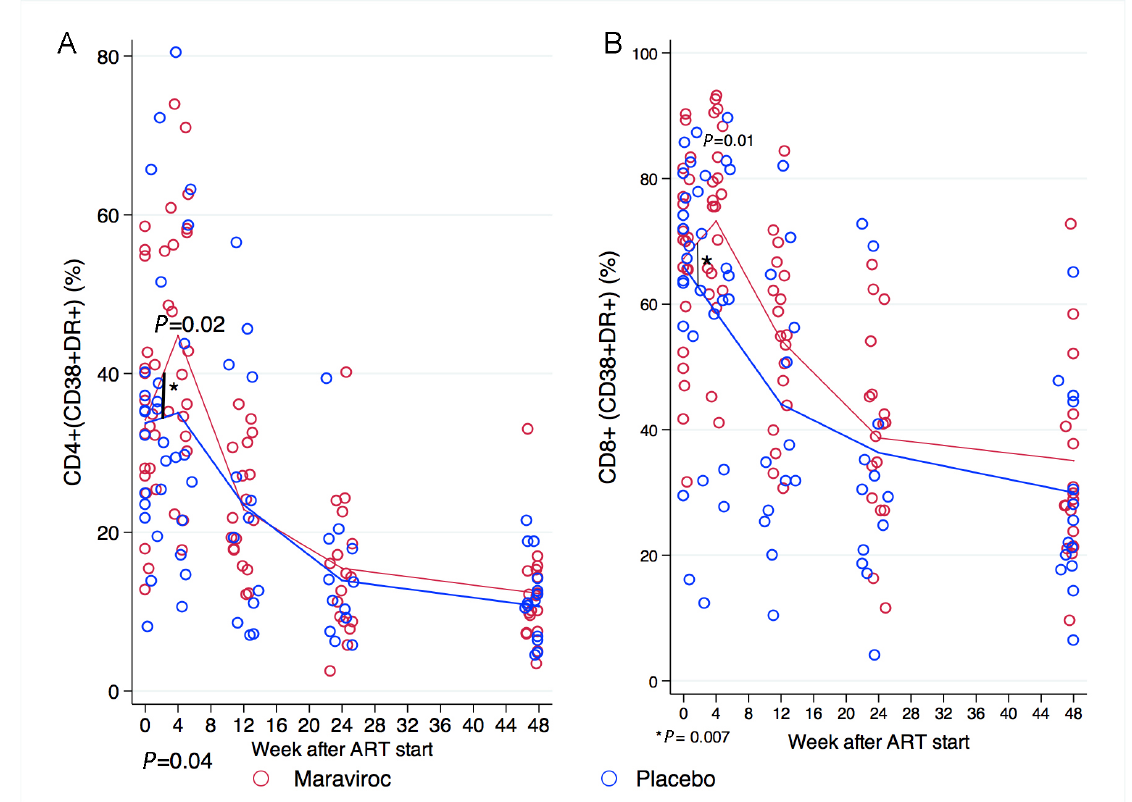
Figure 5. Proportion of activated (CD38+DR+) CD4+ and CD8+ cells over 48 weeks. The proportion of activated A) CD4+ and (B) CD8+ cells was similar at baseline in both groups. In the first 4 weeks, partic- ipants receiving maraviroc experienced a greater increase in the proportion of activated CD4 and CD8 cells than those receiving placebo, and had higher counts of activated CD4+ and CD8+ cells at week 4. Thereafter the proportions of activated CD4+ and CD8+ cells fell in both groups such that by week 12 and thereafter the proportions of activated CD4+ cells were similar in the treatment arms. Note that the scale in the Y-axis differs for each panel. Comparisons between treatment arms are depicted when P < 0.05. Comparisons in the rate of change between 1 time point to the next are indicated by a vertical line and asterisk when P < 0.05. The P-values were derived from mixed linear models using linear combination of coefficients after model